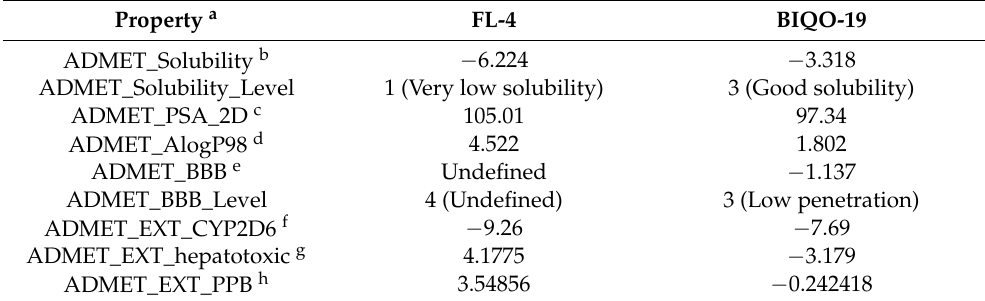
Table 1. Pharmacokinetic profiles of FL-4 and BIQO-19 as determined by in silico